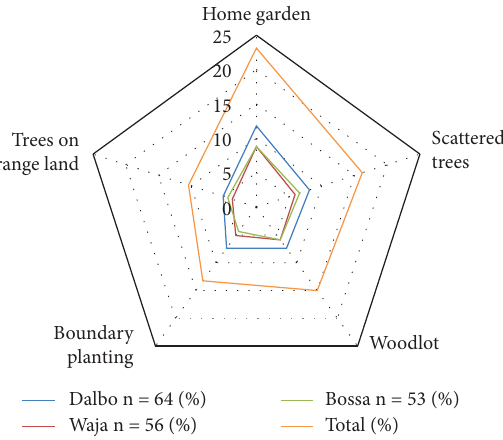
Figure 3: Spider graph of agroforestry practices adopted (source: own survey, 2021). Table 4: Perception of the respondent on the adoption of agroforestry